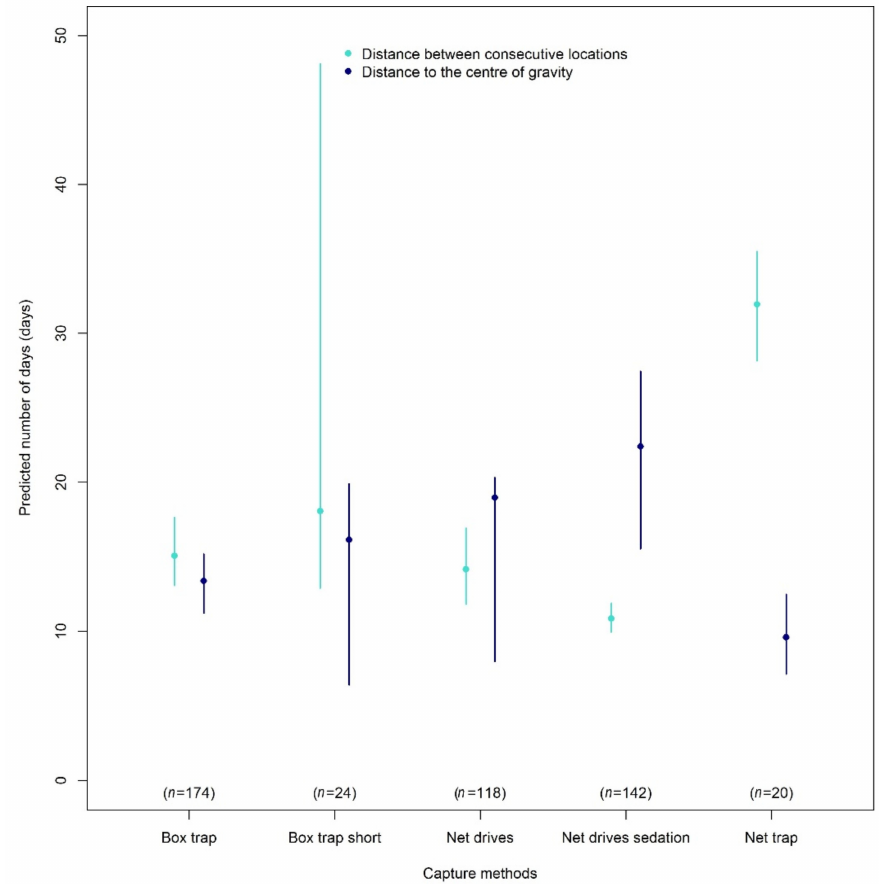
Figure A3. Recovery time for distance to centre of gravity, and between successive locations, for the five roe deer capture